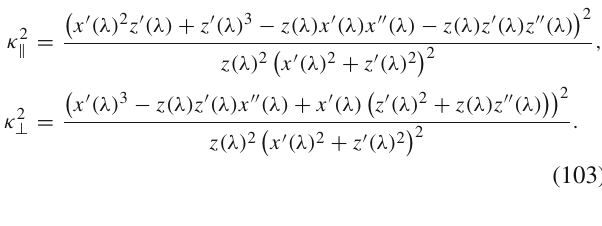
= delimit the region on the boundary that is spacelike separated from x m P from which any chosen green curve must not exit. Starting from the top left, our choice of center curve is x μ (λ) , from which the c